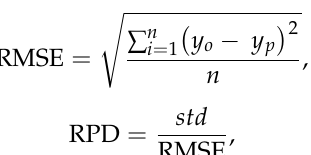
Table 2. Descriptive statistics of the soil organic carbon content in the calibration and validation dataset of the loam belt and Luxembourg areas.